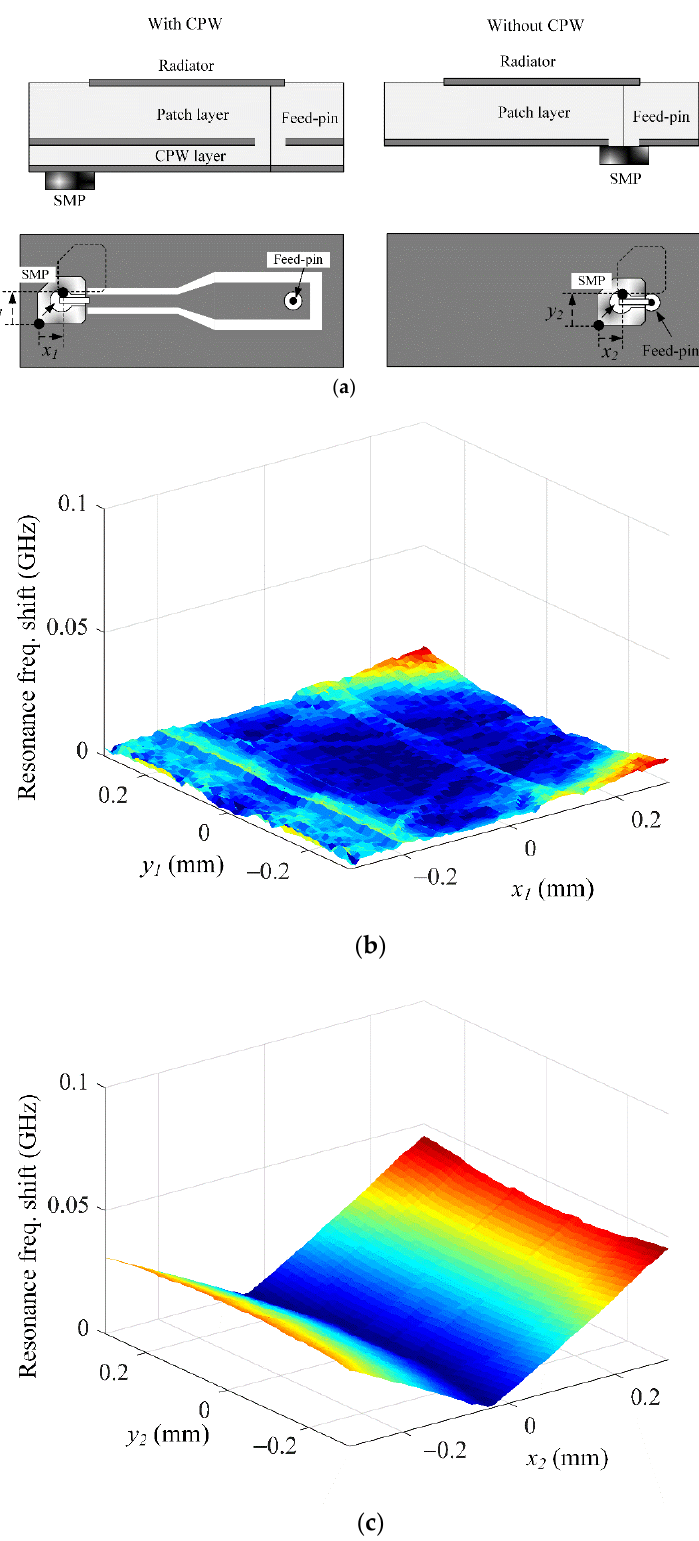
Figure 6. Resonance frequency shift according to the SMP connector movement: ( a ) geometry of the SMP connector movement with and without the CPW layer; ( b ) with CPW case; ( c ) w/o CPW case.